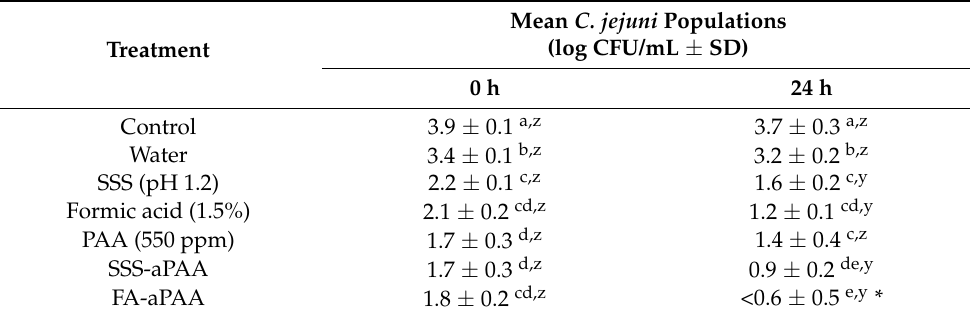
Table 2. Mean ( n = 6) Campylobacter jejuni populations (log colony-forming units [CFU]/mL ± standard deviation [SD]) for inoculated (six-strain mixture; 3 to 4 log CFU/mL) chicken wings that were left untreated (control) or were immersion-treated (5 s, 500 mL of solution per sample) with various treatment solutions.